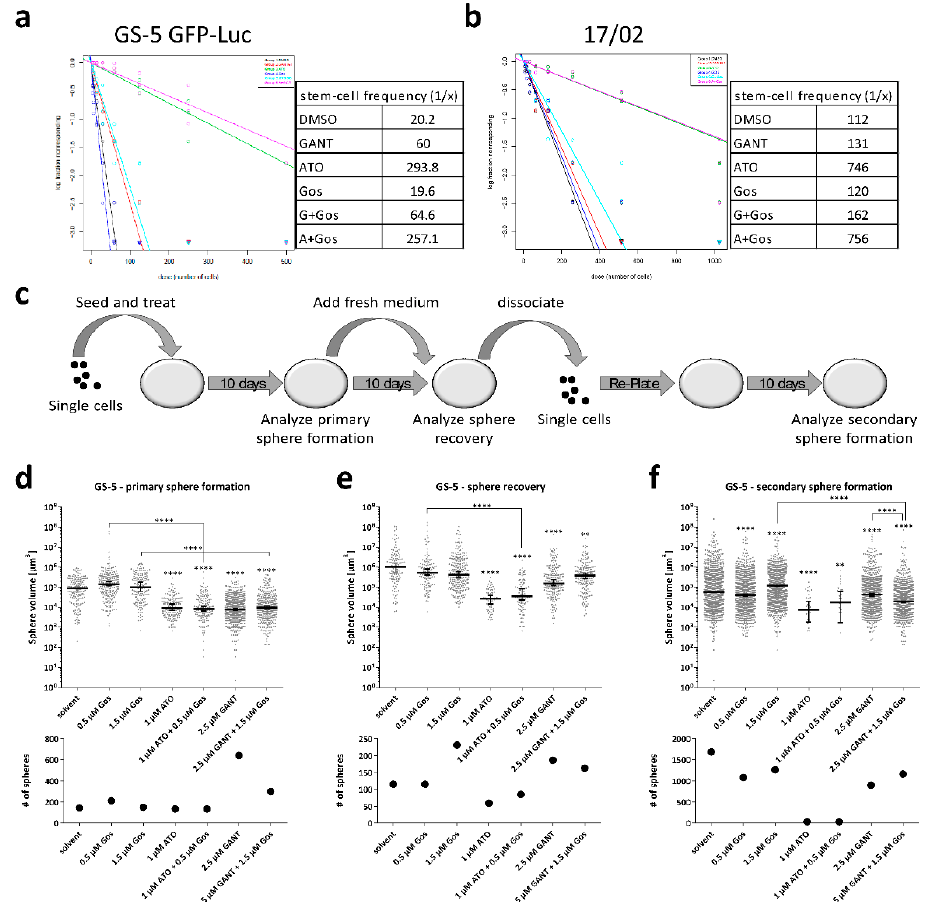
Figure 5. ATO and Gos treatment reduces stemness properties of GS ‐ 5/GS ‐ 5 GFP ‐ Luc and 17/02 in vitro. ( a and b ) Extreme limiting dilution analysis [34] of ( a ) GS ‐ 5 GFP ‐ Luc and ( b ) 17/02 7 days after seeding and treatment with 1 µ M ATO, 2.5 µ M GANT61 or 0.5 µ M Gos alone or in combinaton of increasing cell numbers (4 to 500 cells for GS ‐ 5 and 8 to 1024 for 17/02). The stem cell frequency calculated by ELDA software [34] is depicted next to the graph. ( c ) Scheme of the extended SFA. ( d – f ) Dot ‐ Plots displaying the (upper row) sphere volume and (lower row) total number of spheres of GS ‐ 5 spheres after measurement of primary sphere formation, sphere recovery and secondary sphere formation. Lines in ( d – f ) are the median ± 95% confidence intervals. Limiting dilution assays were performed three times in 12 biological replicates. Sphere formation assays were performed twice in triplicates and three vision fields were analyzed for each biological replicate. * p < 0.05; ** p < 0.01; *** p < 0.001; **** p < 0.0001. One ‐ way ANOVA followed by Tukey Post ‐ Hoc ‐ Test (GraphPad Prism 7). The LDA revealed that treatment with ATO and ATO/Gos treatment reduced the stem ‐ cell fraction about 15 ‐ and 7 ‐ fold in GS ‐ 5 and 17/02, respectively, whereas GANT or GANT/Gos treatment only reduced the stem ‐ cell fraction 3 ‐ fold in GS ‐ 5 and only slightly in 17/02. In contrast, Gos did not change the ratio of sphere ‐ forming vs total cells. GS ‐ 8 reacted similar to GS ‐ 5 (Figure S7)